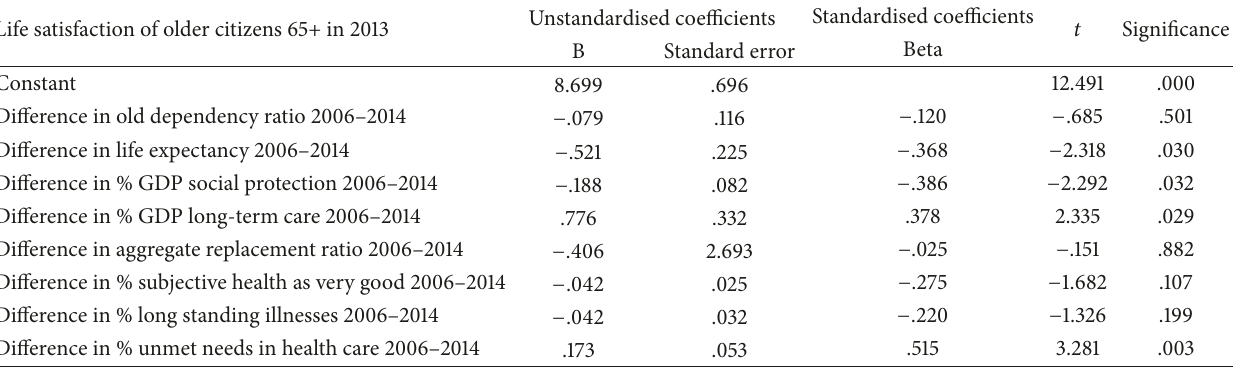
Table 6: Regression analysis and enter method, between changes in independent variables between 2006 and 2014 and life satisfaction of citizens of 65 years and older in 2013 as dependent variable in 31 European